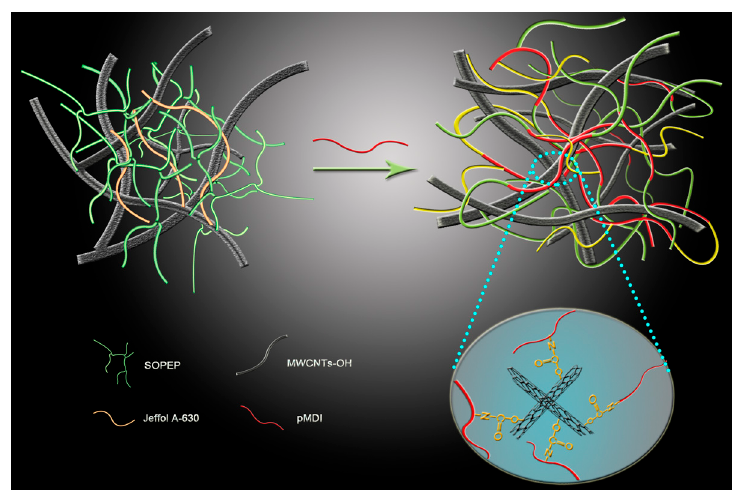
Figure 9. Schematic diagram of the three-dimensional (3D) macromolecular network structure Figure9. Schematicdiagramofthethree-dimensional(3D)macromolecularnetworkstructureformation formation of the nanocomposite bioplastic. of the nanocomposite